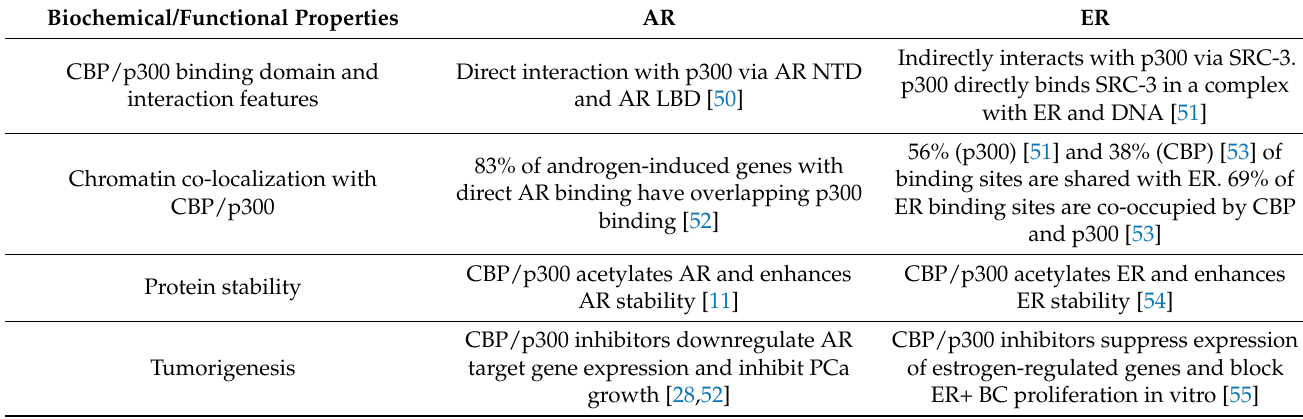
Table 1. Characteristics of the interactions of CREB-binding protein (CBP)/p300 with the androgen receptor (AR) and estrogen receptor